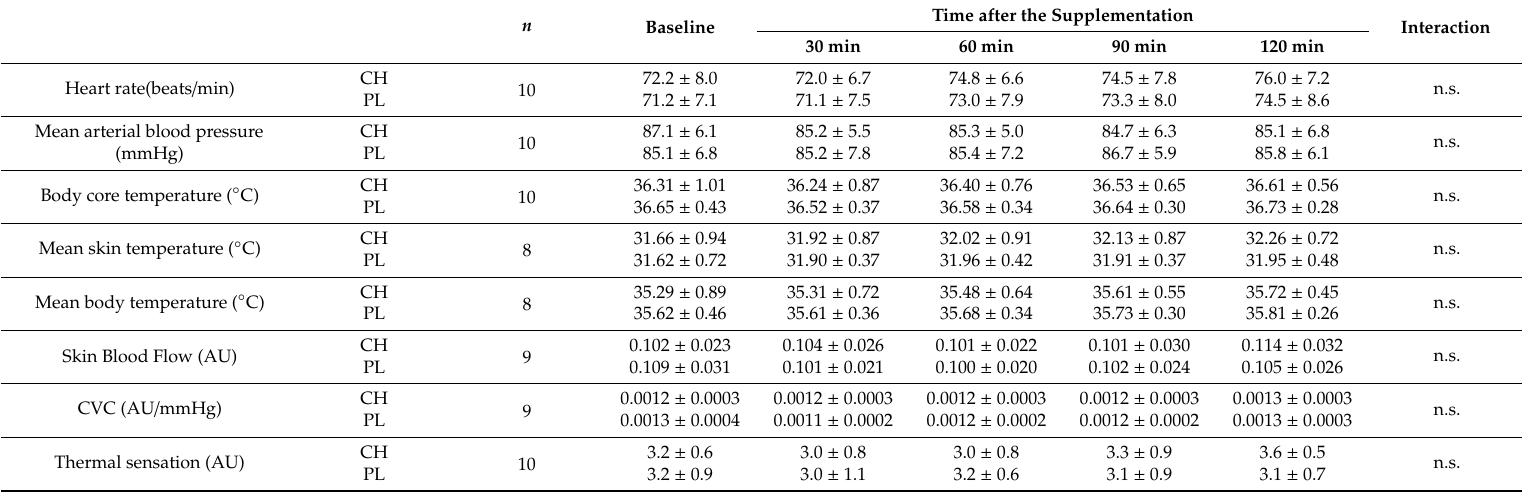
Table 2. Physiological and perceptual responses in the preliminary